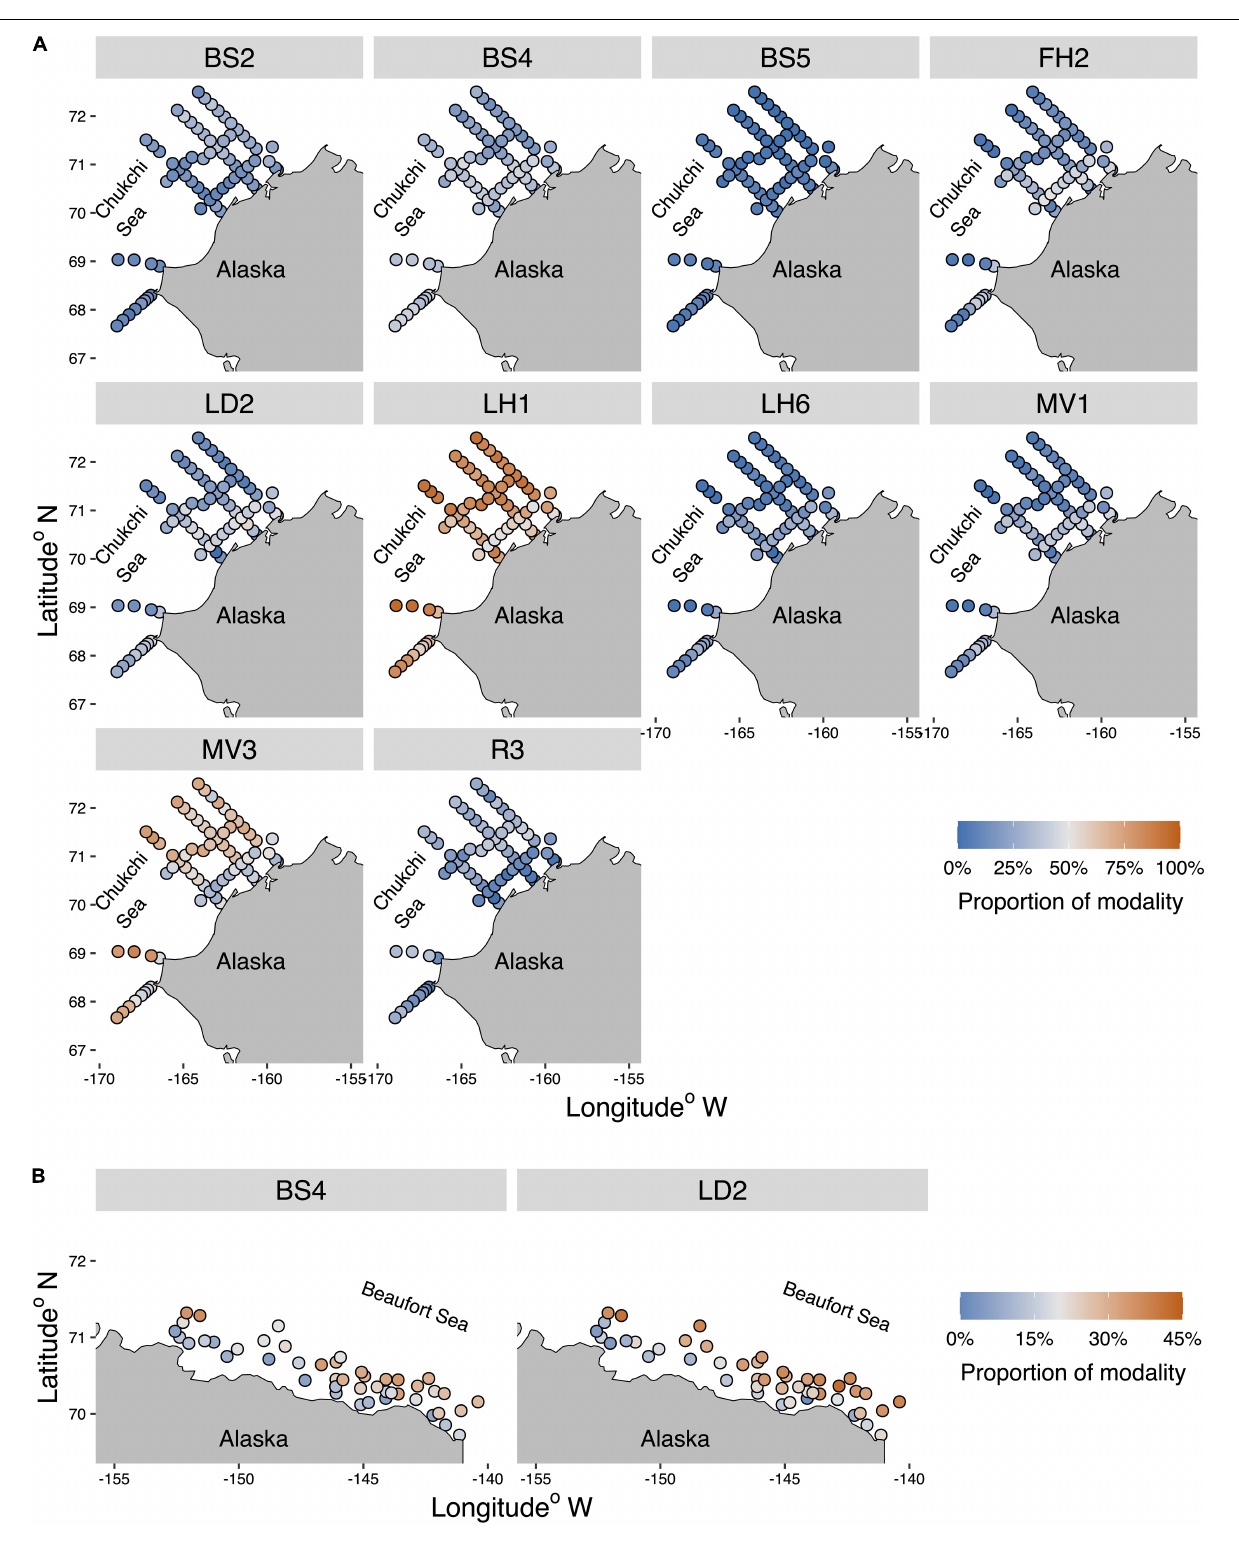
Frontiers in Marine Science |